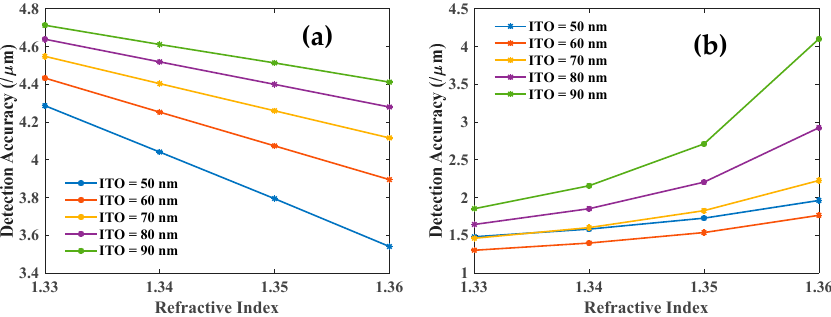
Figure 10. Detection accuracy of the ( a ) first LMR and ( b ) SPR dip with the variation of third ITO layer for 10 nm thick first layer ITO and 10 nm thick Ag layer.